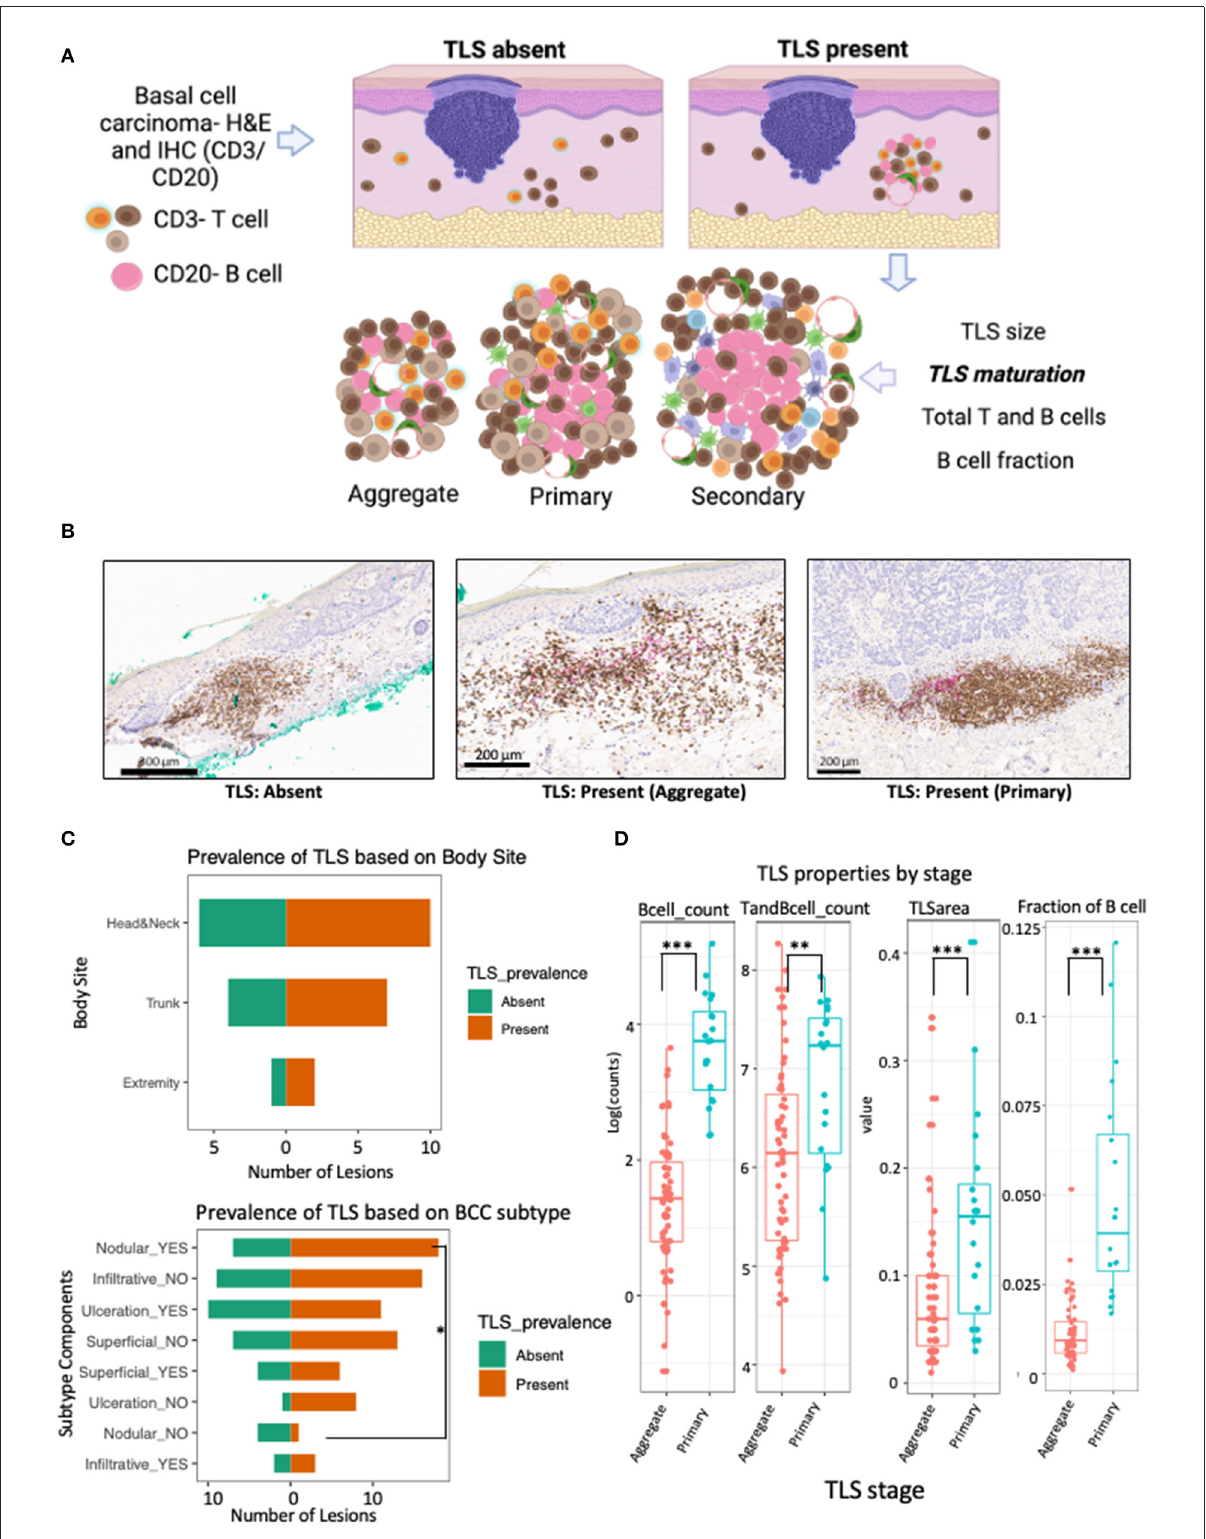
FIGURE1 TLS prevalence and maturation depends on BCC subtype and anatomical location. (A) Schematic workflow for evaluation of TLS prevalence and maturation. TLS presence was defined as presence and co-localization of both CD3 + T cell and CD20 + B-cell along high endothelial venules